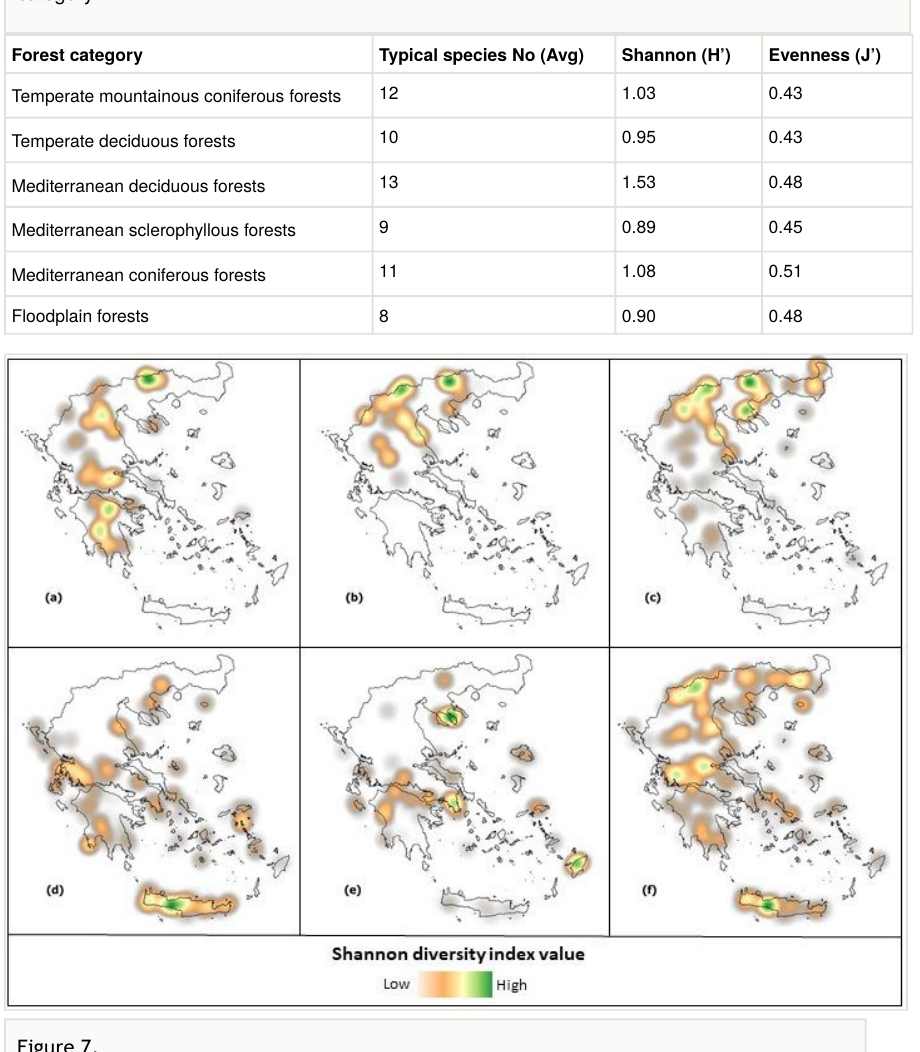
Typical species average number, Shannon and Evenness indices for each forest ecosystem category.